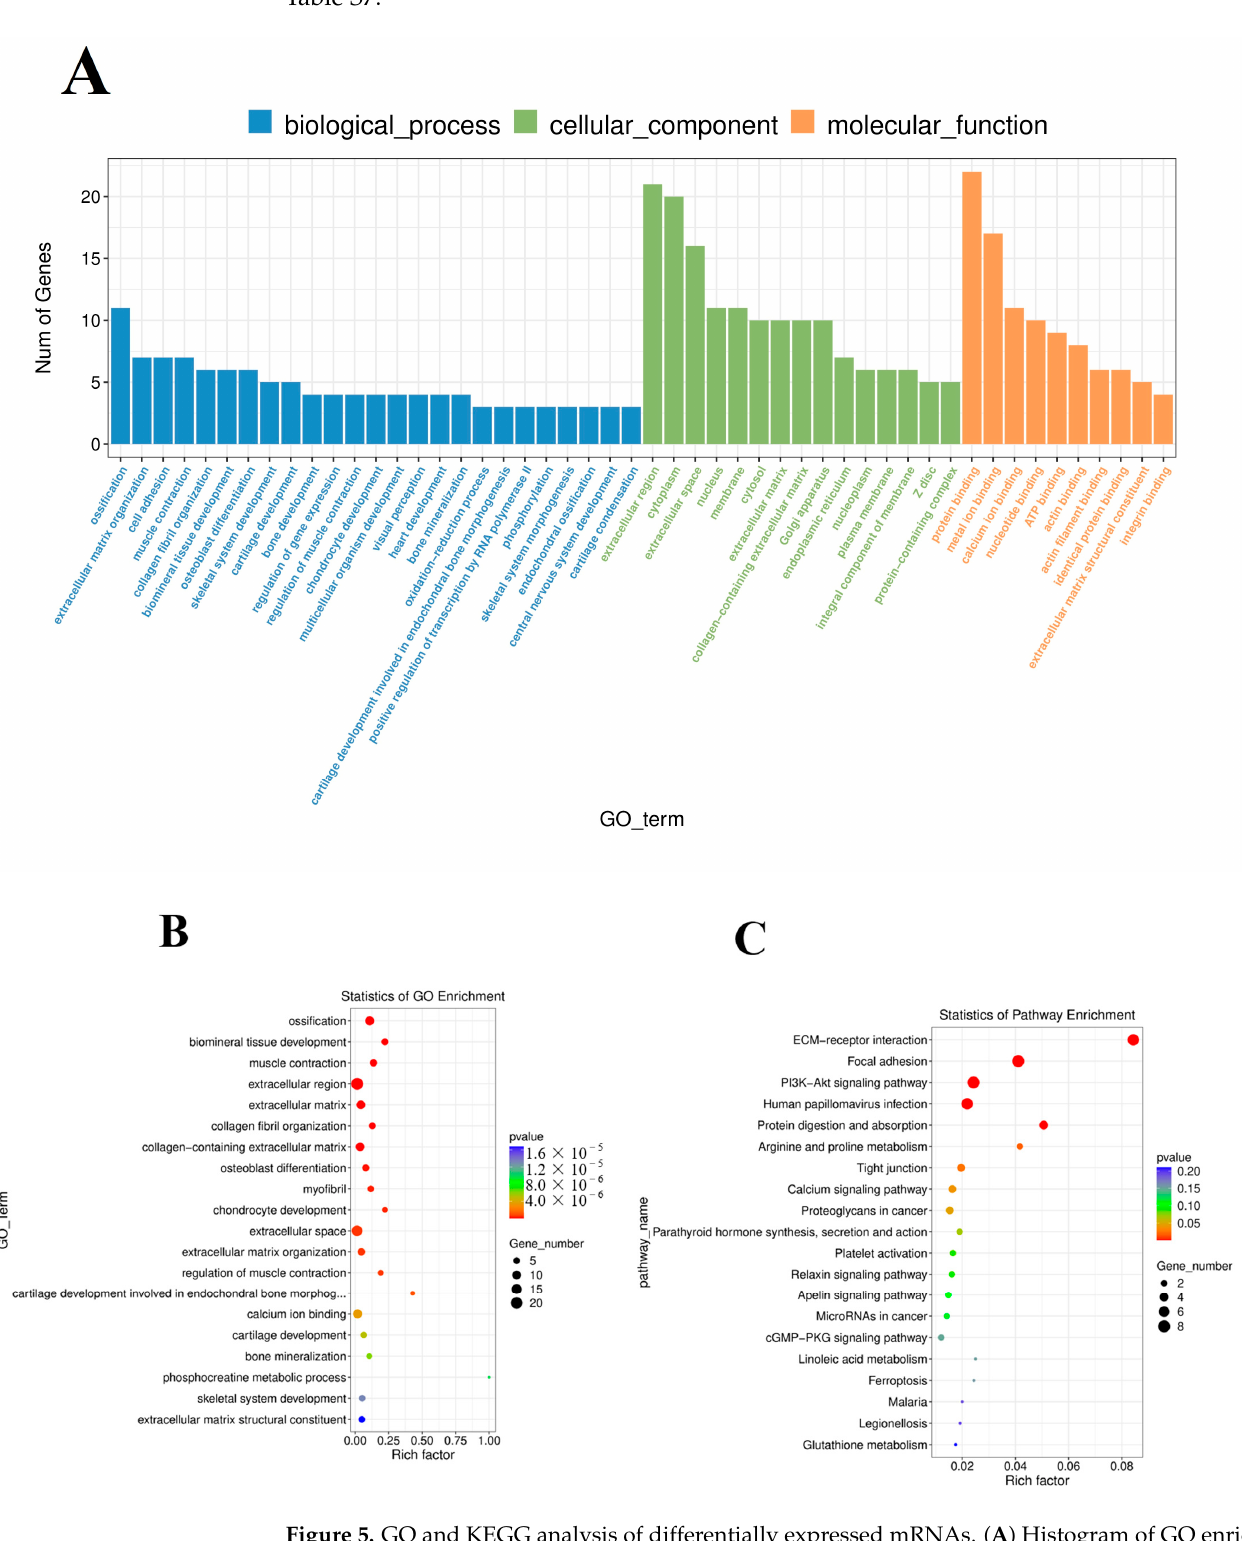
Figure 5. GO and KEGG analysis of differentially expressed mRNAs. ( A ) Histogram of GO enrich- ment of DE mRNAs. ( B ) Scatter plot of GO enrichment for DE mRNAs. ( C ) Scatter plot of KEGG enrichment for DE